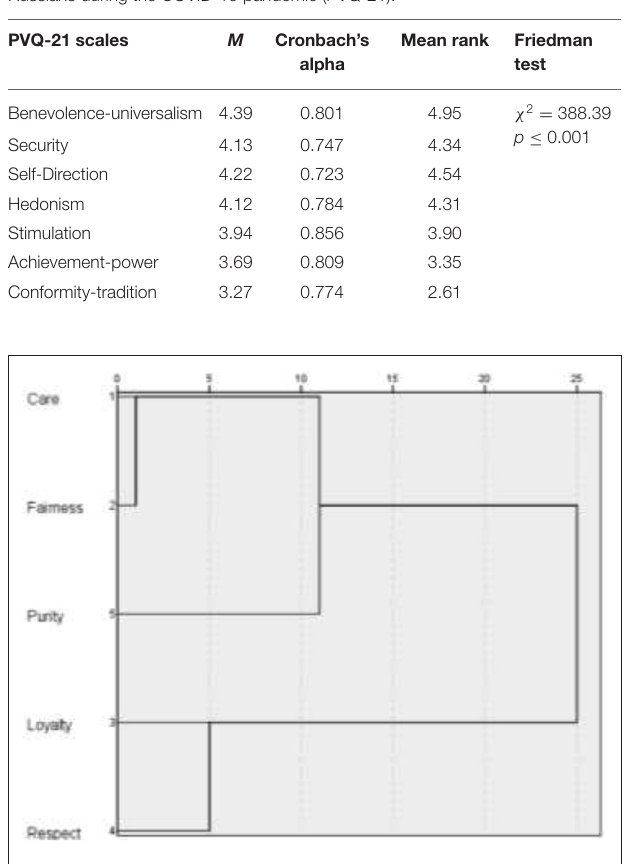
FIGURE 1 | Classification of Russians’ moral norms during the COVID-19 pandemic (MFQ). Dendrogram of hierarchical cluster analysis (intergroup communication